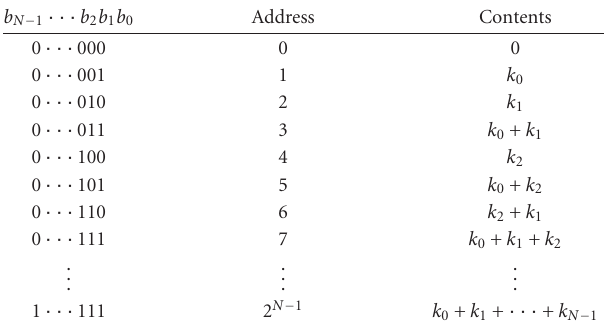
Figure 4: Implementation of an IIR biquadratic section on an Xilinx Virtex FPGA. Table 1: Contents of a DA ROM. For each address, the terms k i for which b i = 1 are